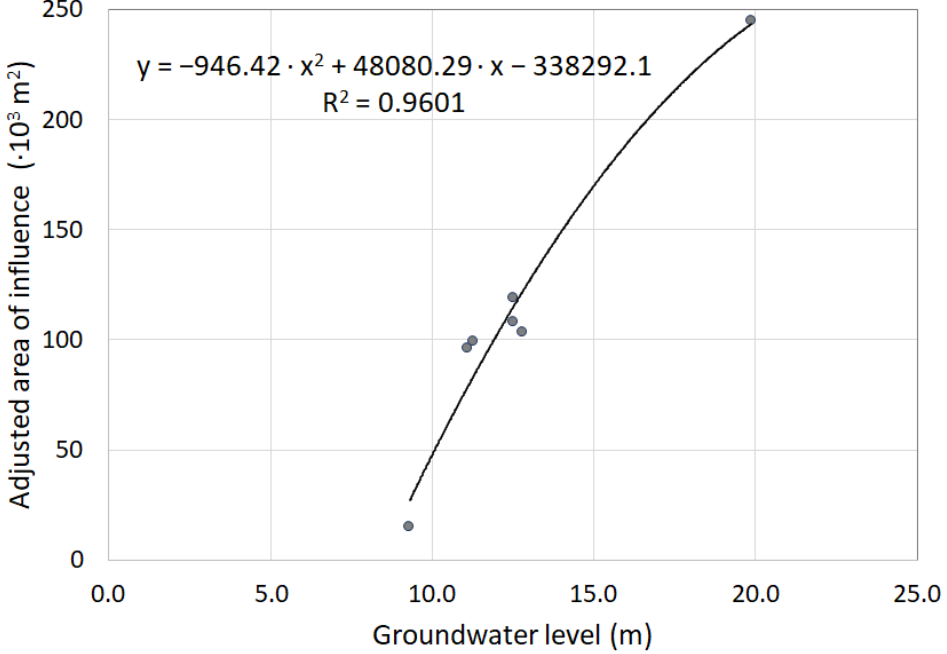
Figure 6. Relationship between the groundwater levels measured with the piezometer Tu 43/83 and the springs discharges. Table 6. Reliability of the estimates. Location Measured Variable Predicted Variable Area of influence Kristal